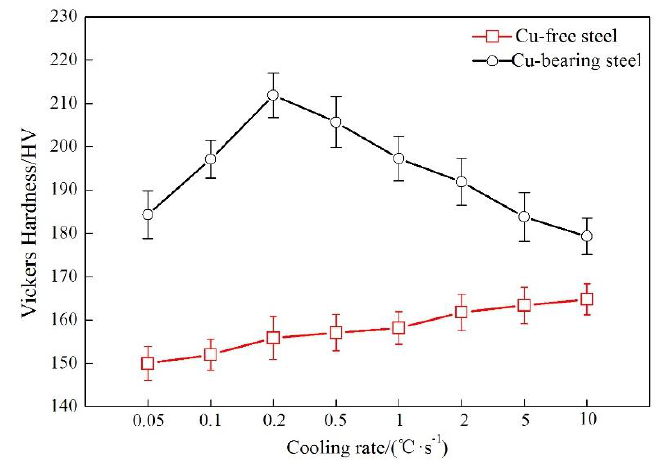
Figure 3. Variation of Vickers hardness of ferrite as a function of cooling rate for the two steels.